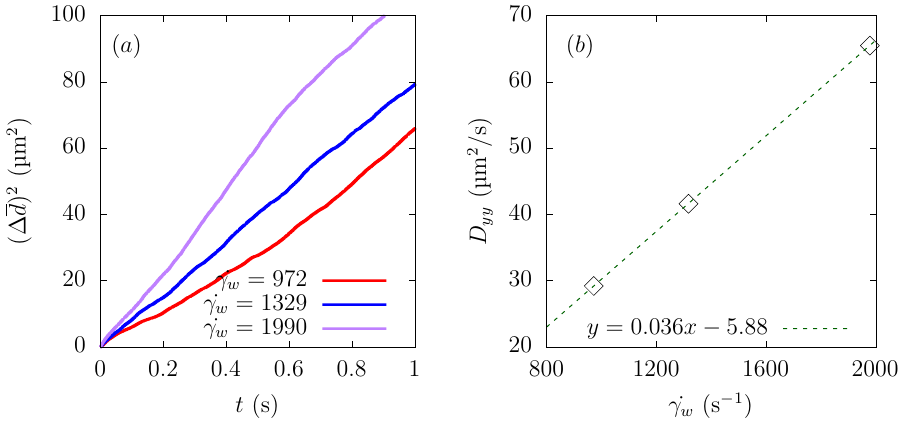
Figure 12. Calculation of the diffusion coefficient from the mean-squared displacement. ( a ) Time history of ( ∆ d ) 2 based on the result of Figure 6. ( b ) Relationship between wall shear rate ˙ γ w and the diffusion coefficient D yy determined from